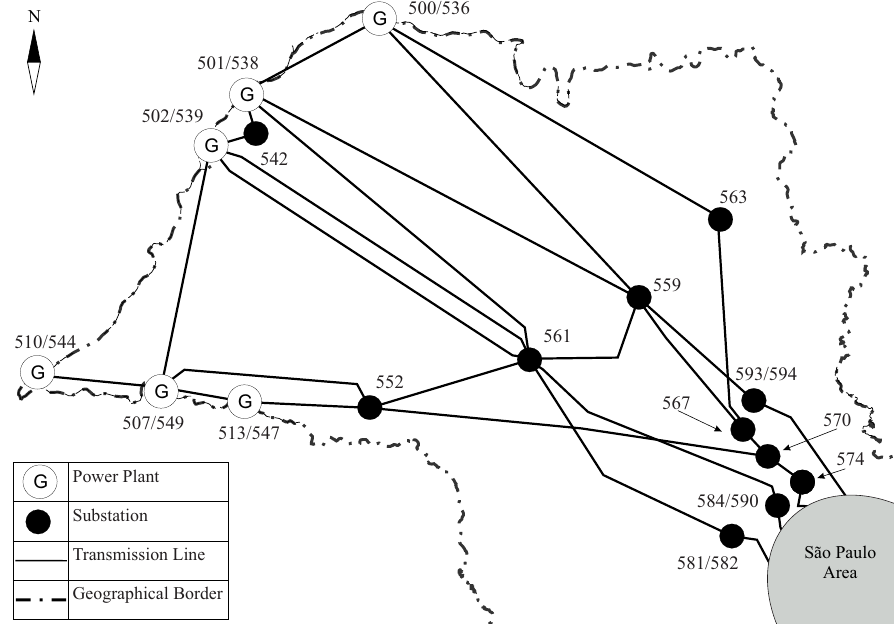
Figure 3. Geographical representation of the São Paulo State power grid. The highlighted area represents the state’s capital